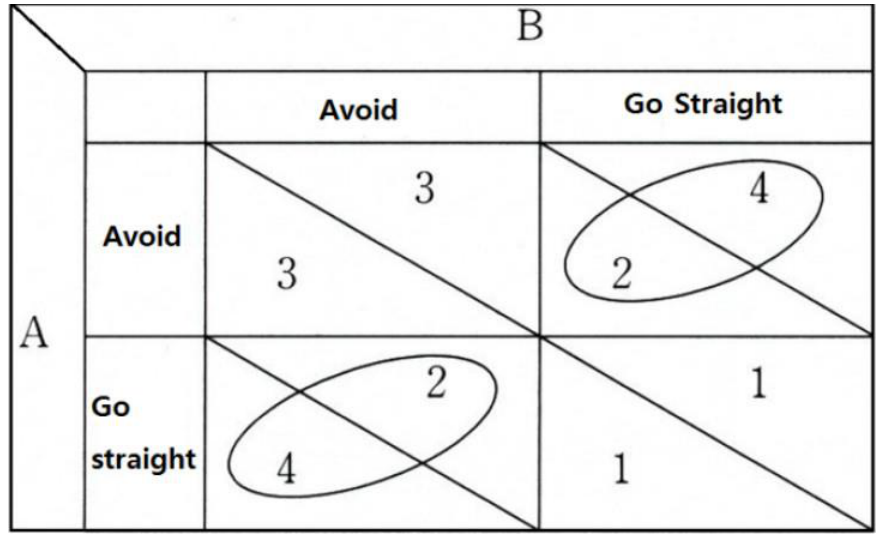
Figure 10. Representation of Zigbee-based communication as a Normal-form Game and Expression of an Elliptic part by the Nash Equilibrium solution.